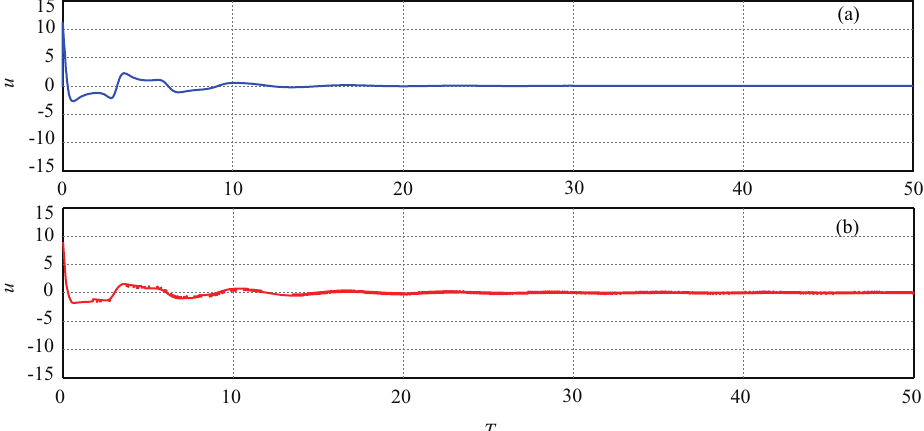
Figure 5. Curves of the dimensionless control input with a continuous disturbance [( a ) Proposed method; ( b ) Method in